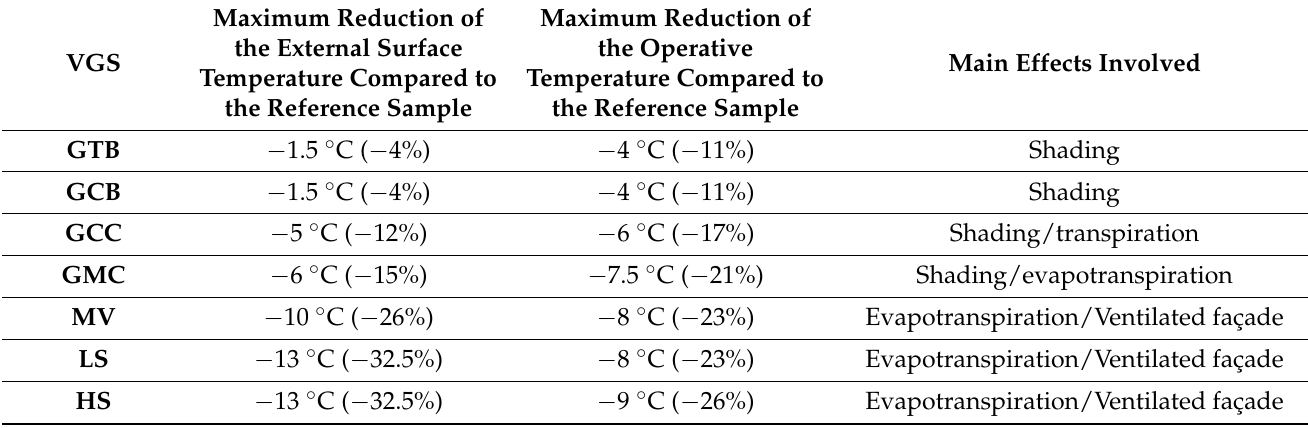
Table 5. Summer. Comparison of the results obtained on the south wall of the sample during the daytime and evaluation of the main variables involved for each category.